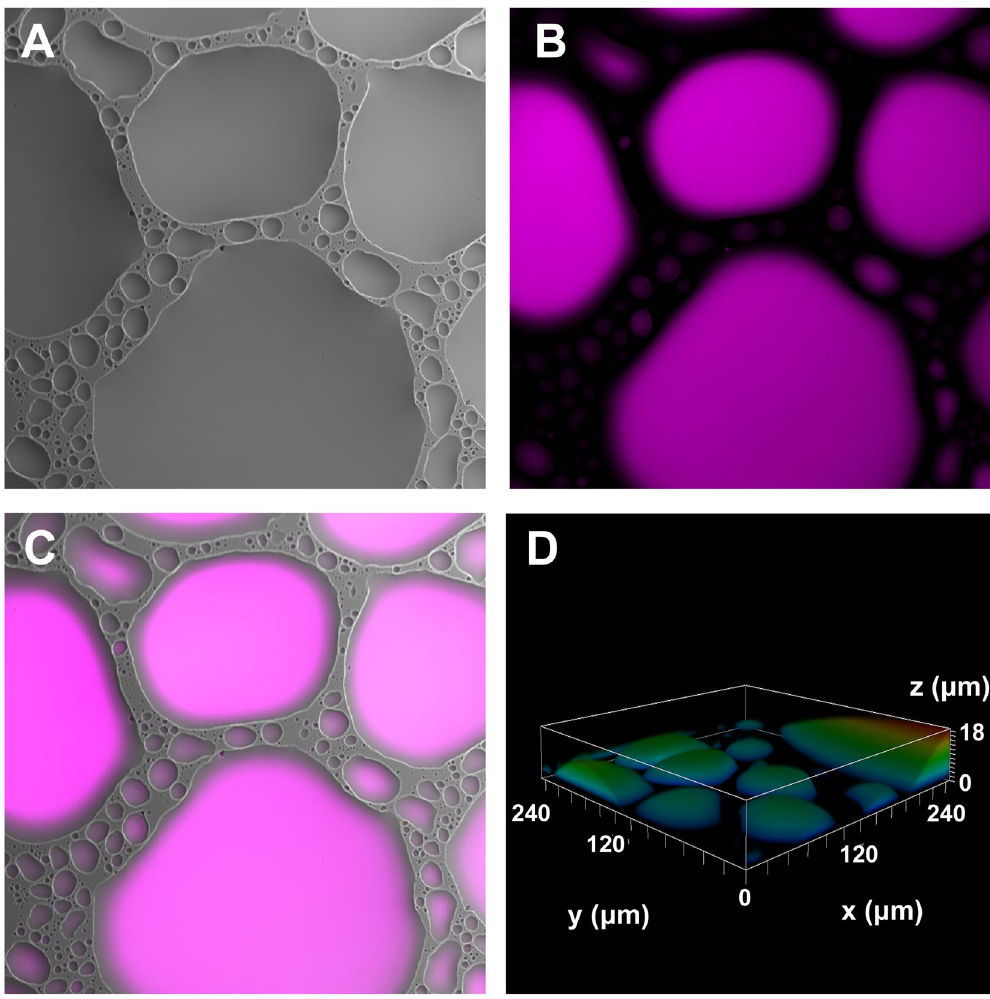
Figure 3. Autofluorescence as a marker of e-liquid deposition. 25 × 70 mL puffs of Grape Soda generated at 40 W were vaped over a glass coverslip and imaged. ( A ) Transmitted light image showing textured e-liquid deposition. ( B ) XY-confocal image of the same e-liquid, following excitation at 405 nm. ( C ) Merged images. ( D ) 3D rendering of e-liquid deposition using ~60 z-stack